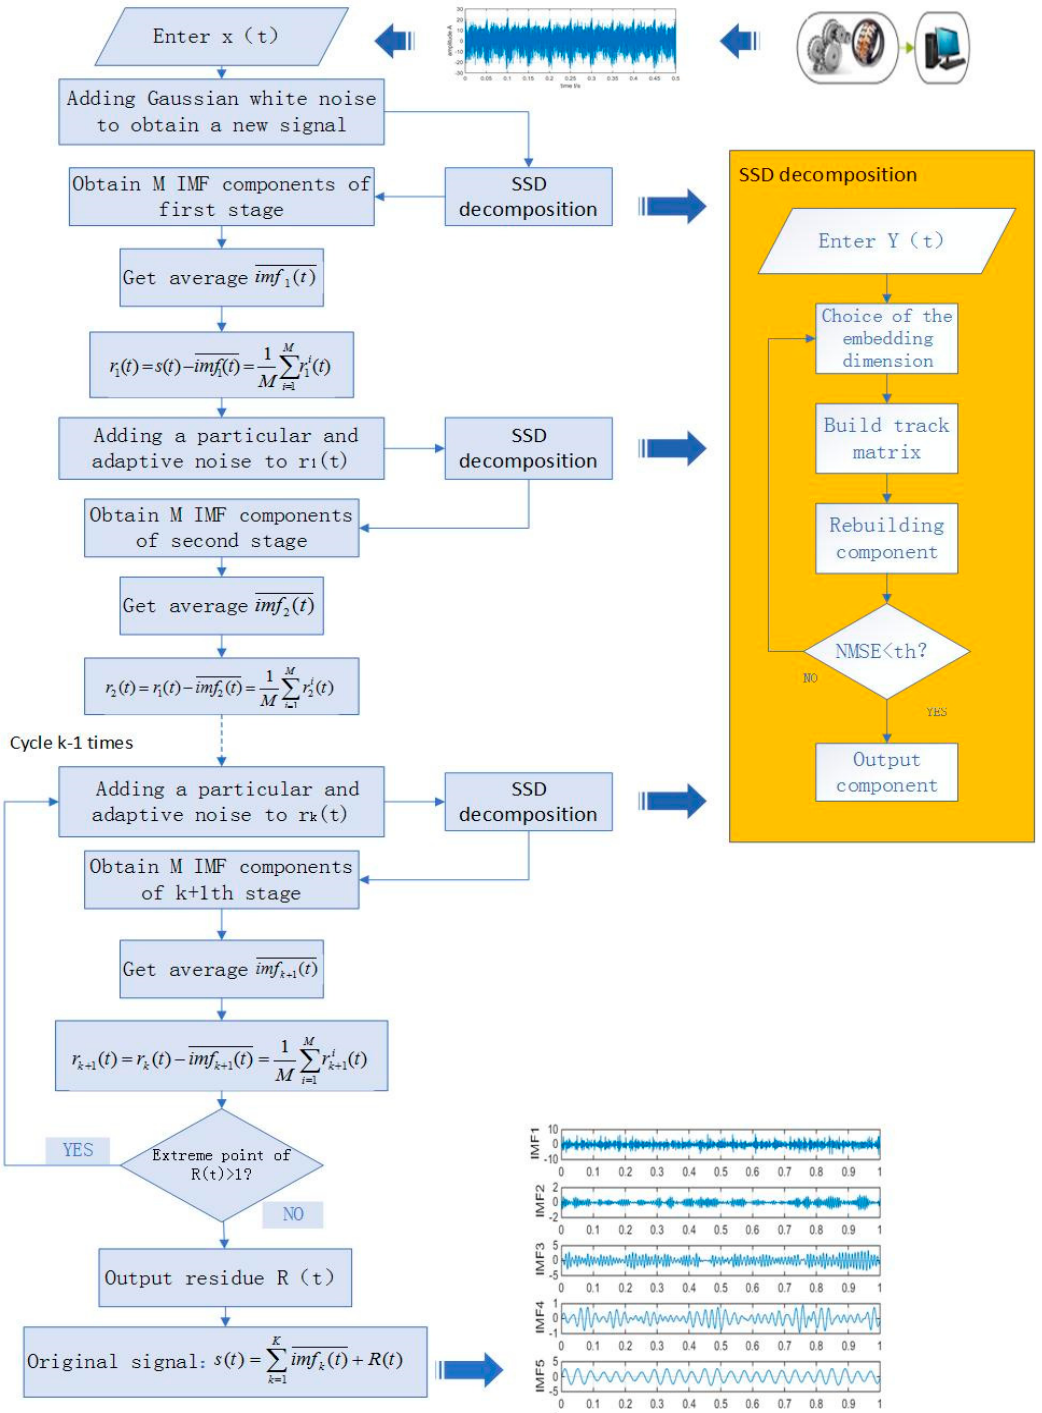
Figure 1. Flow chart of the MSSD.